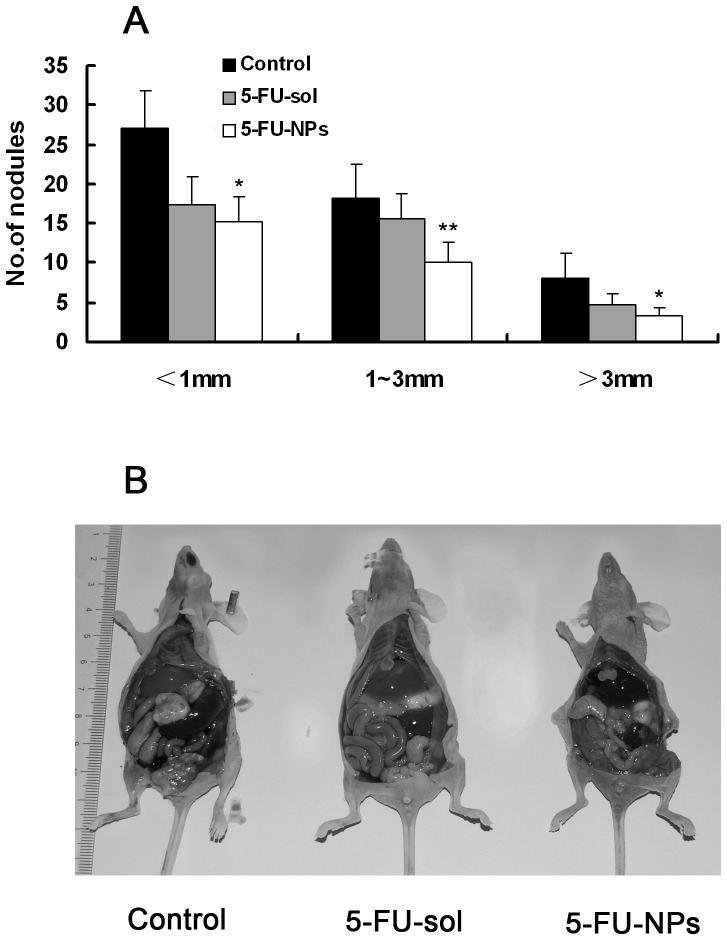
Anti-tumor nanoparticles may inhibit nodules formation of colon cancer peritoneal metastasis in nude mice.(a) Metastatic nodules in abdominal cavity were counted according to diameter less than 1 mm, 1∼3 mm or more than 3 mm. (b) Visible tumor nodules were present in the abdominal cavity in representative photos of nude mice were sacrificed 4 weeks after i.p. injection with HCT116 cells.